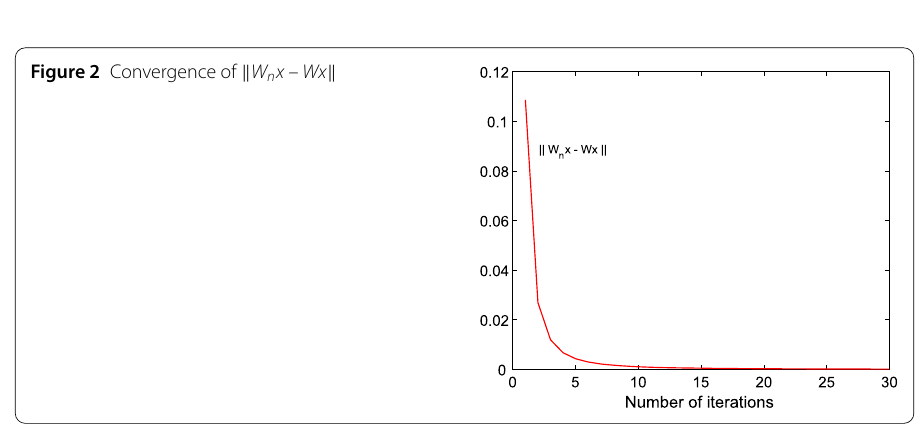
Figure 2 Convergence of (cid:3) W n x – Wx